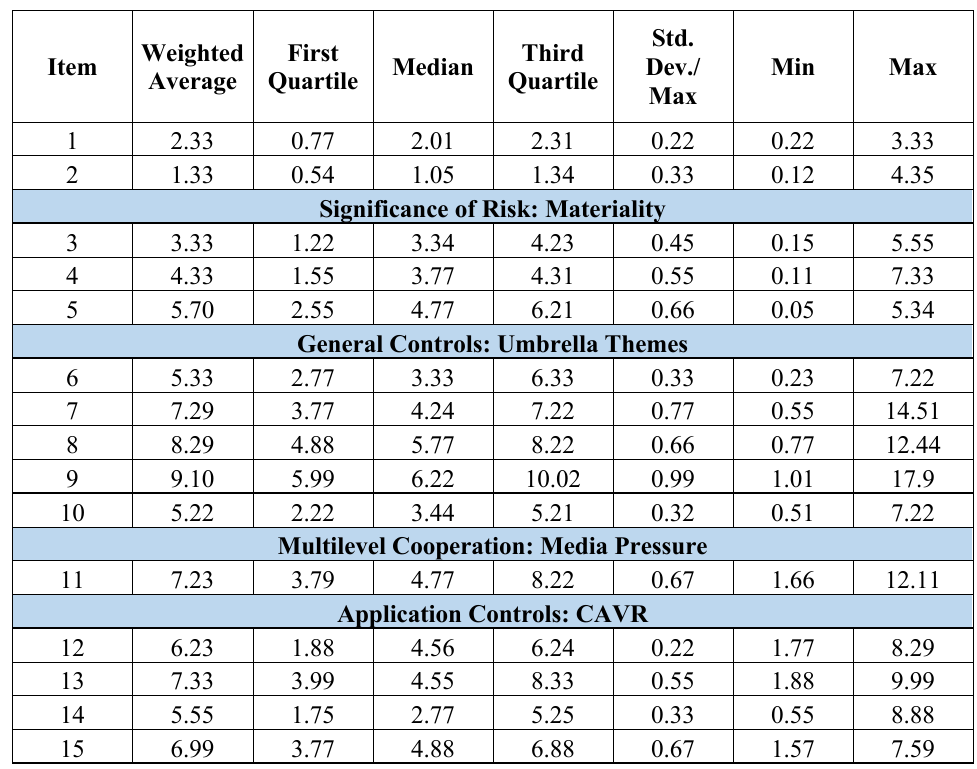
Table 5. Critical Dimension of the Agile Marketing Capability. Number of Observations: 100% of AGEA Debt Register Practices year 2014 (Number of Observation 4.887 Practices) Source: Our Elaboration of AGEA E&Y Up Grade Procedure Services